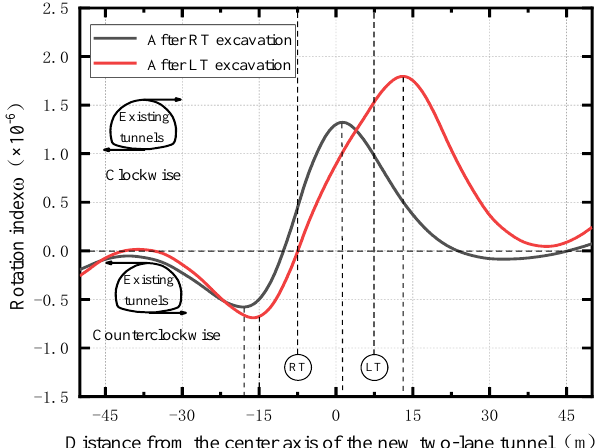
Figure 17. Longitudinal rotation index distribution of the existing tunnel.